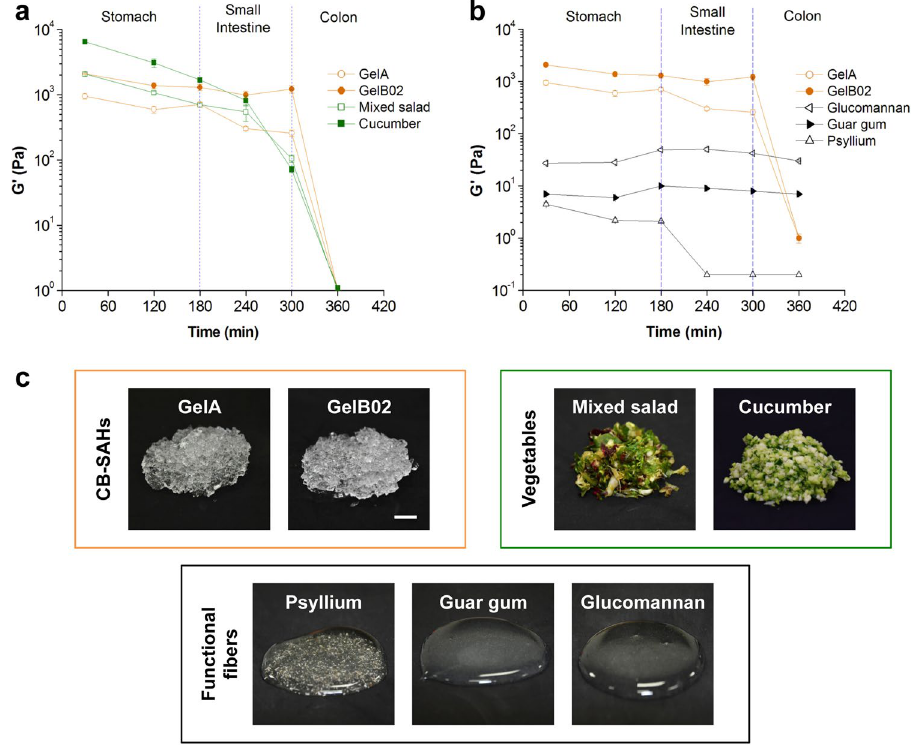
Figure 5. Comparing the mechanical properties of CB-SAHs, vegetables and functional fibers in simulated GI conditions. Elasticity (G ′ ) of GelA and GelB02 compared with that of ( a ) minced raw vegetables and ( b ) functional fibers, as assessed by means of an in vitro simulated GI model (n = 3 at each time point, mean ± SD; plots produced with Origin 6.0, www. origi nlab. com). ( c ) Visual appearance of hydrated CB-SAHs, minced vegetables (with a particle size of about 2 mm, comparable to hydrated CB-SAHs granules) and functional fibers (at 1% w/v) right before testing (scale bar 1